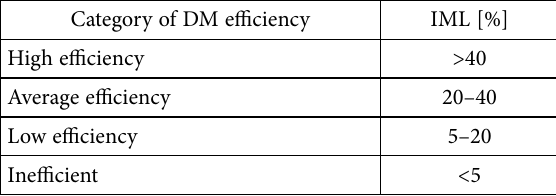
Table 1. Categories of DM efficiency (Bulevičius et al. 2014)